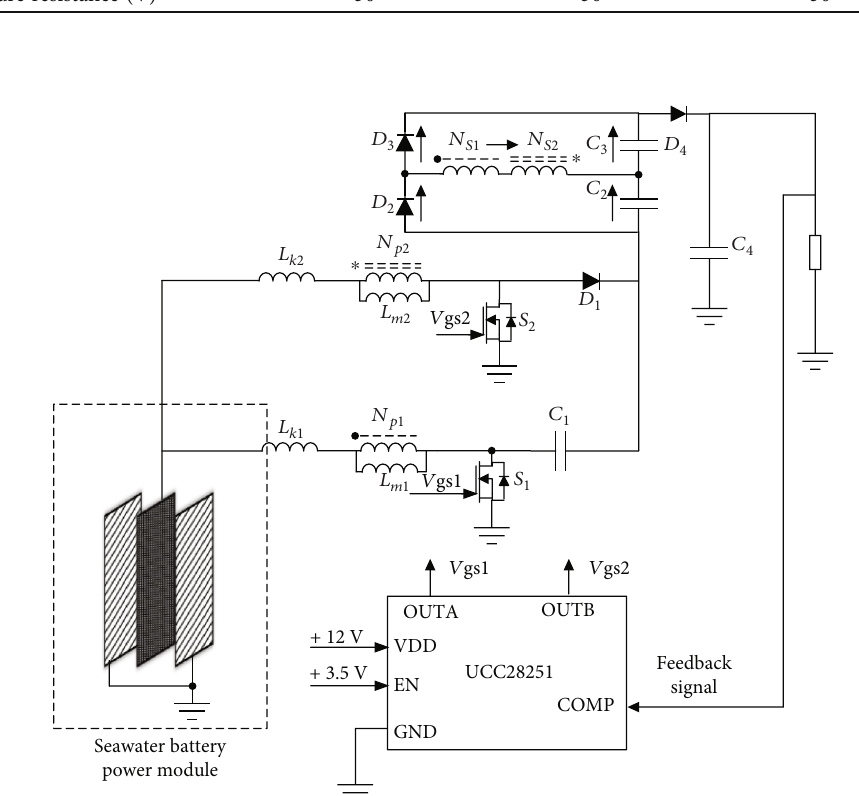
Figure 10: Control strategy for the seawater